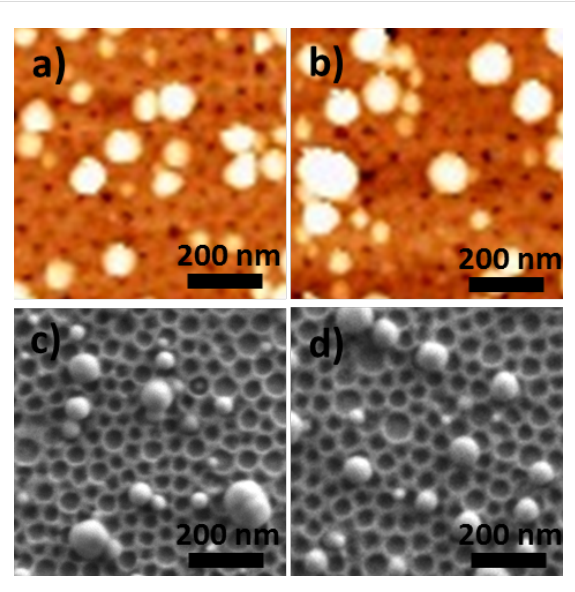
Figure 9: AFM images of a) NC02 , b) NC03 and SEM micrographs of c) NC02 , d) NC03 .